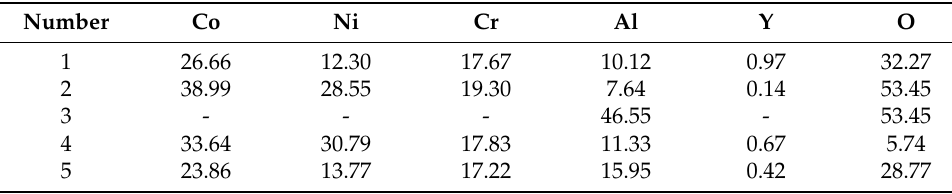
Table 5. EDS analysis results of these positions as marked in Figure 3